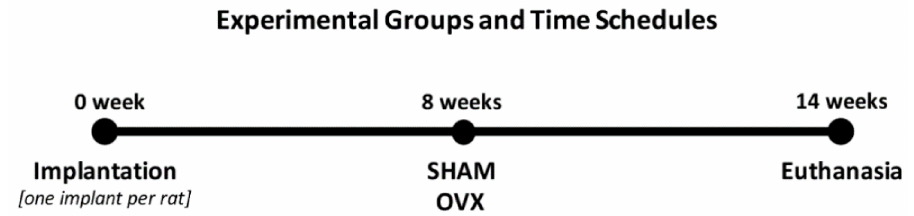
Figure 2. Experimental animal groups and timeline for surgical procedures and sacrifice in the study